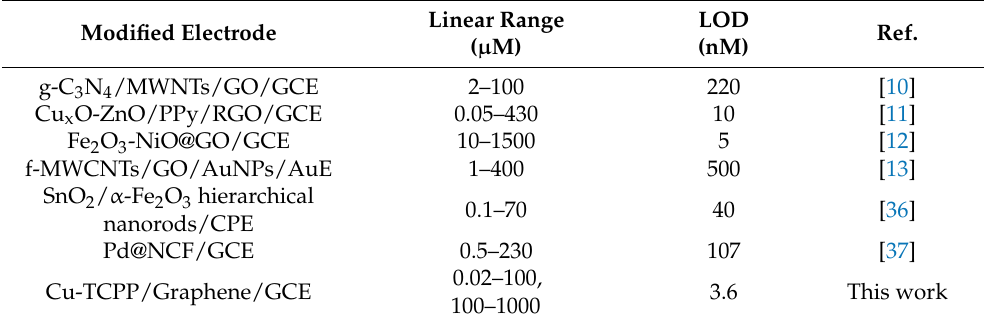
Table 2. Comparison of different modified electrodes for the determination of